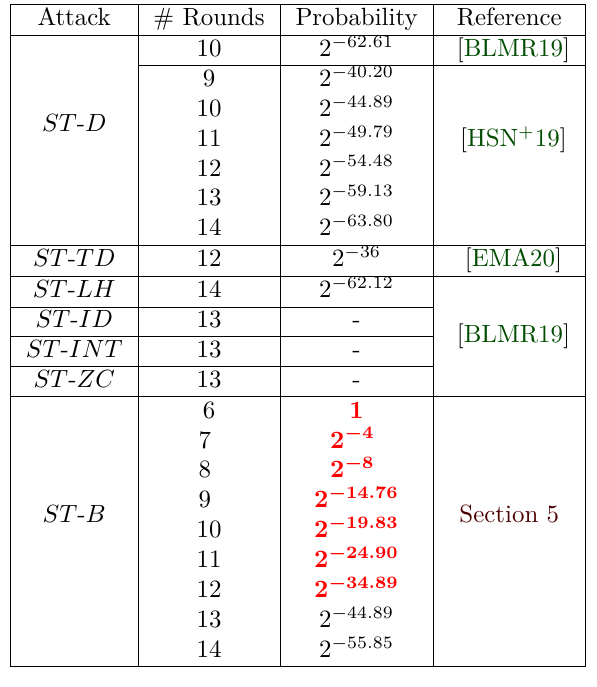
Table 2: Summary of our results and the other known single-tweak attacks on CRAFT . ST , stands for single-tweak, and the boomerang, differential effect, truncated differential, linear hull, impossible differential, integral, and zero-correlation cryptanalysis are respectively denoted by B , D , TD , LH , ID , INT and ZC . The probabilities highlighted in red have been verified